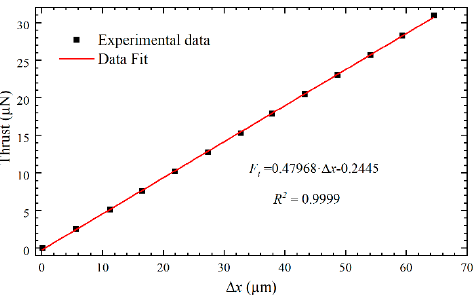
Figure 15. Steady-state calibration results of the torsional balance with the calibration data and the fitting curve.